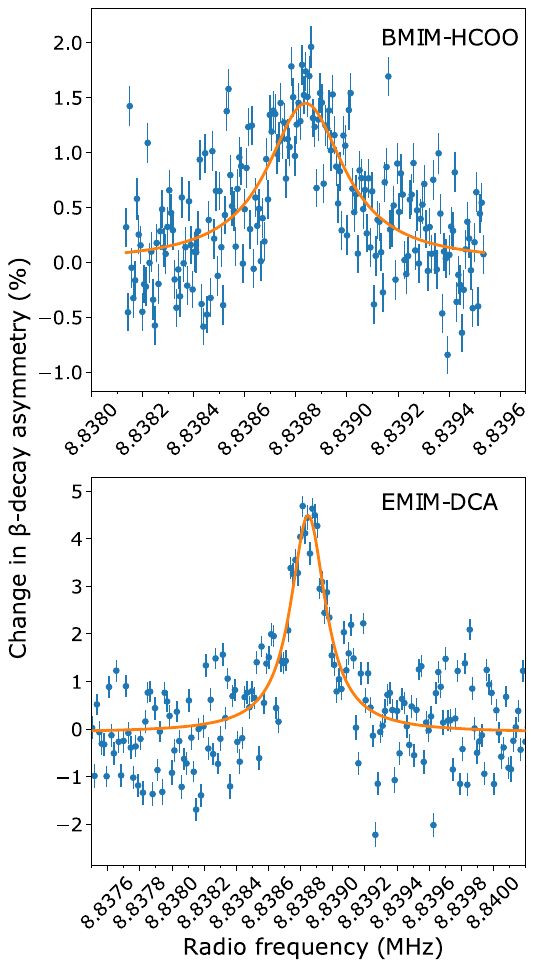
FIG. 3. Examples of 26 Na β -NMR spectra in BMIM-HCOO (top) and EMIM-DCA (bottom). See the text for the description of the fitting procedure. Note the different ranges of x and y axes. The fitted baseline (i.e., experimental asymmetry outside reso- nance) is subtracted for all data points for an easier comparison of the amplitudes of both signals. The magnetic field is locked to the same 1 H frequency for both